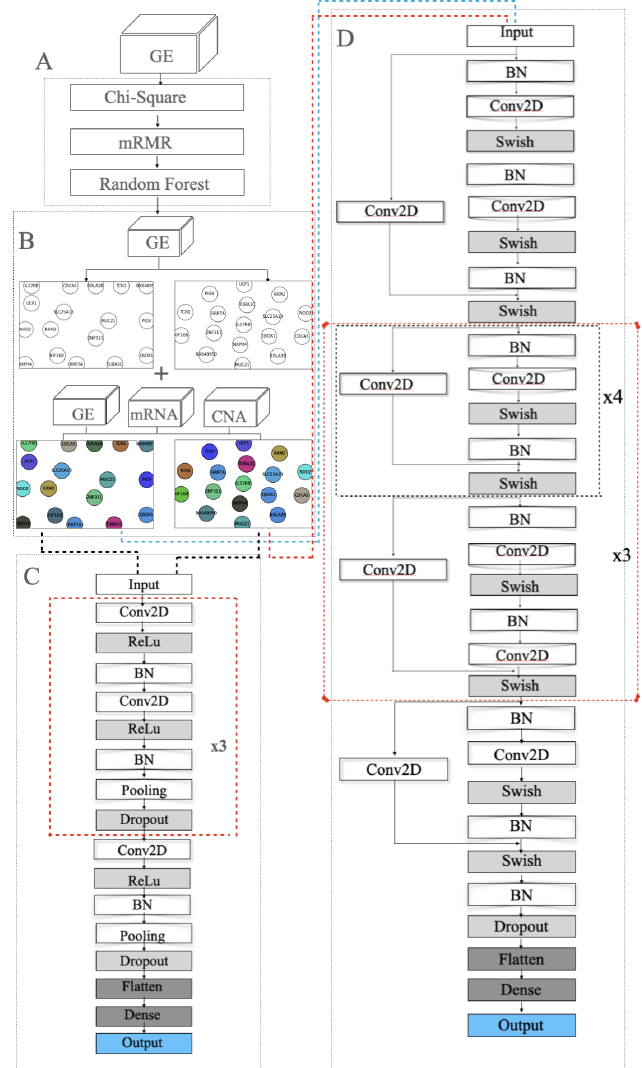
Figure 5. Modelling in the merged approach: ( A ) feature selection using chi-square, mRMR and random forest; ( B ) SOM and t -SNE embedding to draw two 2D templates of the 22 selected genes. The left template was made by SOM and the right template was drawn by t -SNE. The templates are colored by combining the three omic datasets; ( C ) the 33-layer VGG model; ( D ) the 112-layer ResNet